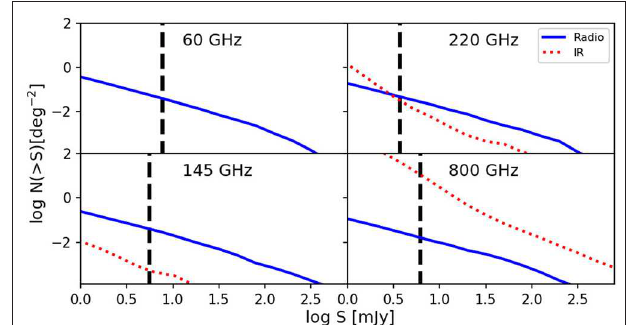
FIGURE 10 | Estimated integral number counts in polarized intensity of radio sources and of dusty galaxies (IR) at 60, 145, 220, and 800GHz. The contribution of dusty galaxies is completely negligible at 60GHz. The vertical dashed black lines show the 5 σ detection limits for a space-borne instrument with a 1.5m telescope and state-of-the-art sensitivity derived from simulations similar to those described in De Zotti et al. (2018). The present simulations assumed log-normal distributions of the polarization fractions with mean and dispersion of 2.14% and of 0.9%, respectively, for radio sources and of 1.4 and 1%, respectively, for dusty